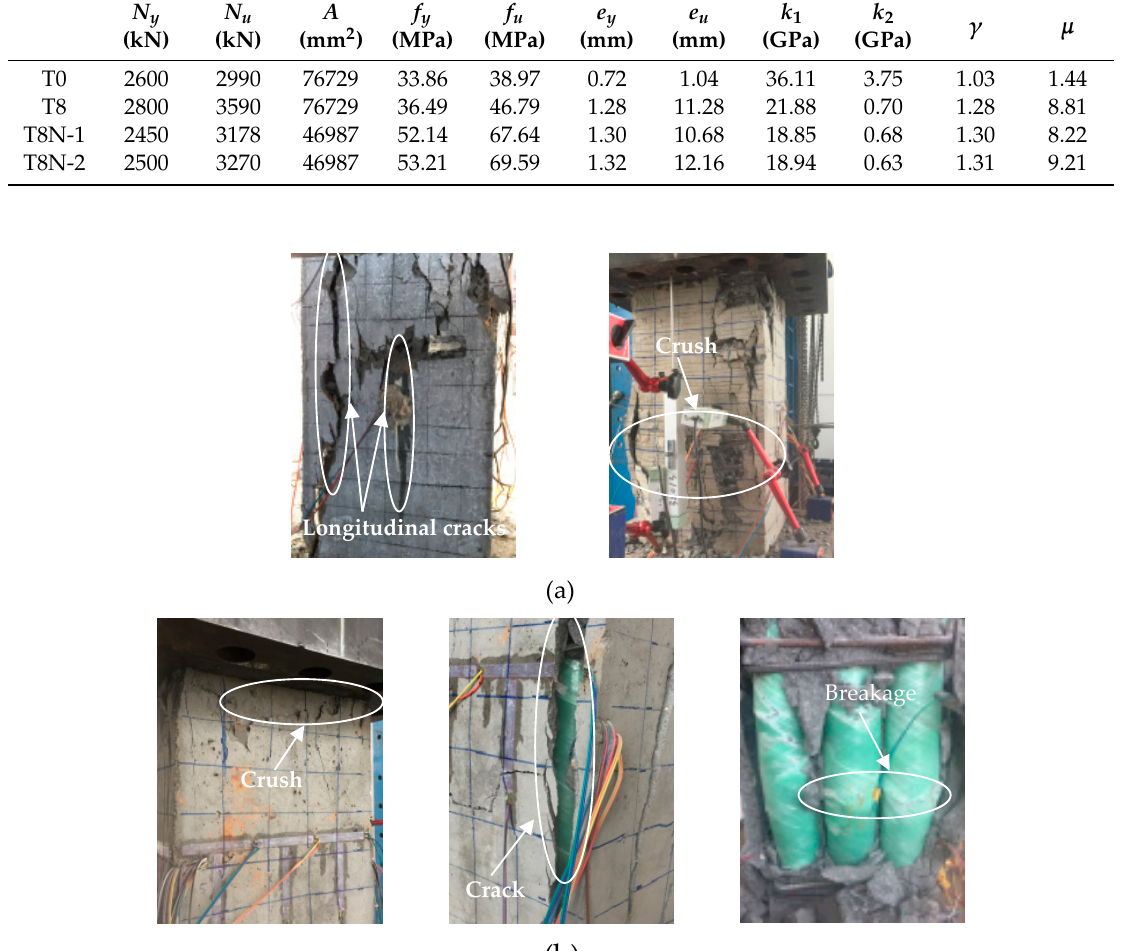
Ball hinge Figure 3. Test setup and instrumentation. 3. Results 3.1. Failure Modes The failure modes of the specimens are shown in Figure 4. The initial damage in all specimens was concrete micro-cracking except for T8N specimens without outside concrete. The failure modes of all EFCCC columns were ruptures of the corner GFRP tubes after large area cracking occurred